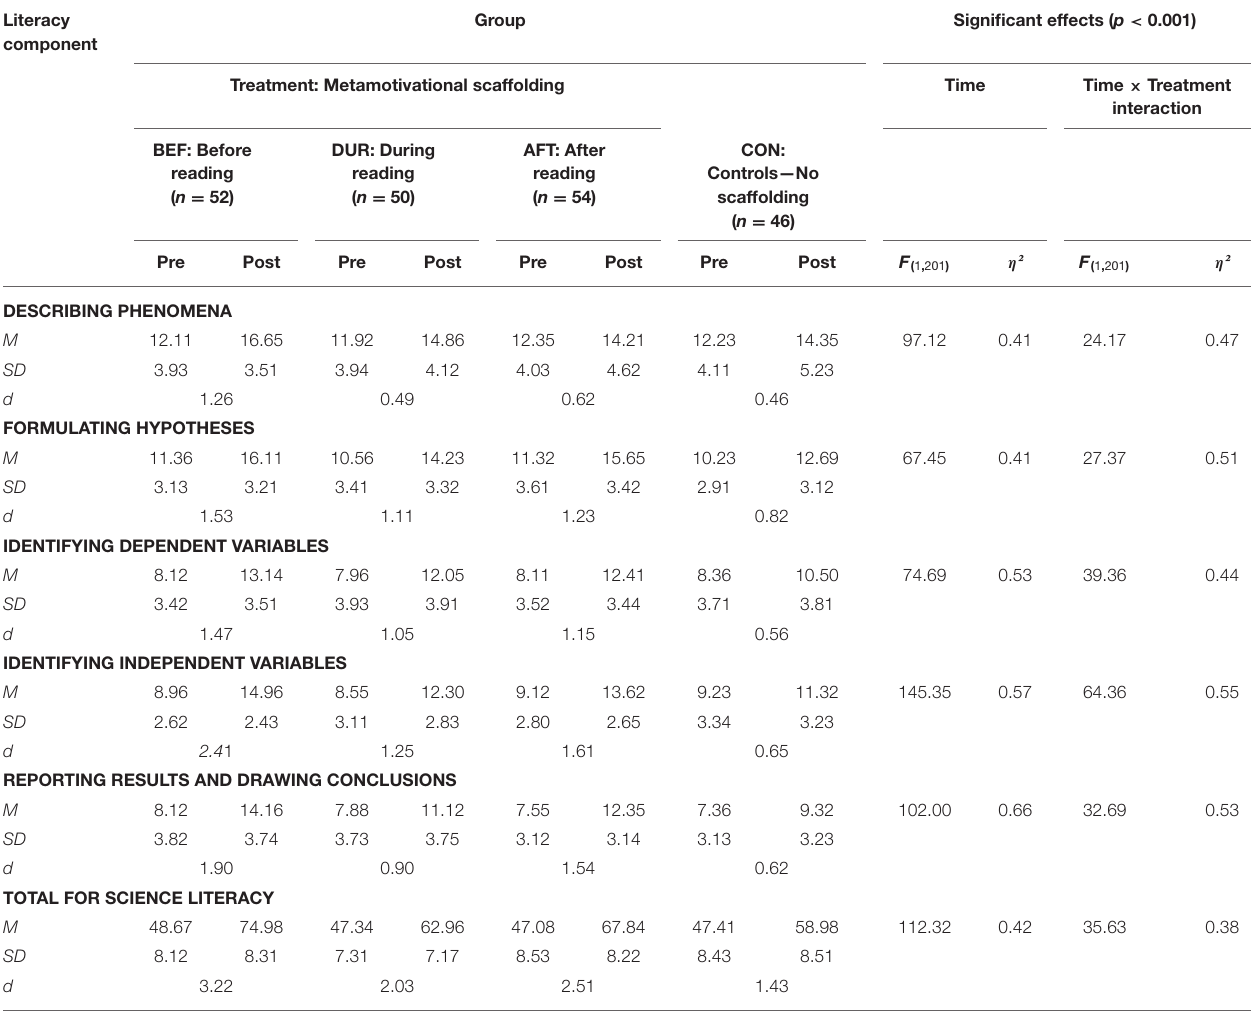
TABLE 6 | Means, standard deviations, and cohen’s d effect sizes a on general test of science literacy, by time and treatment, with significant effects. Literacy Group Significant effects ( p < component